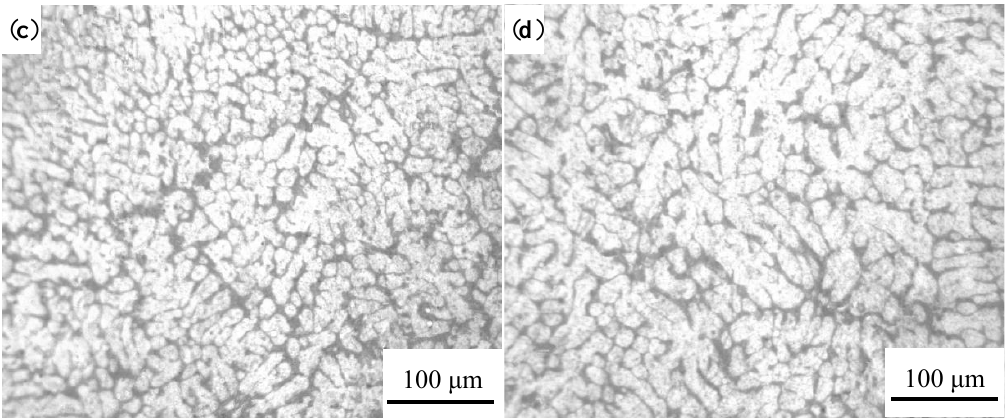
Figure 6. Microstructure of vacuum counter-pressure casting aluminum alloy under different ultrasonic temperature; ( a ) 680 °C, ( b ) 700 °C, ( c ) 720 °C, ( d ) 740 °C.